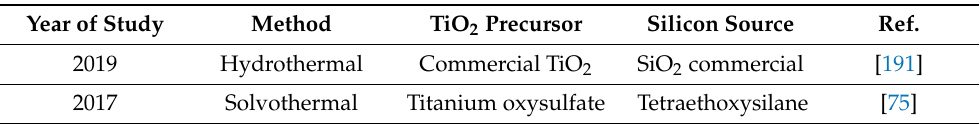
Table 10. Summary of Si/TiO 2 photocatalysts synthesized by variety of methods and source precursor materials.